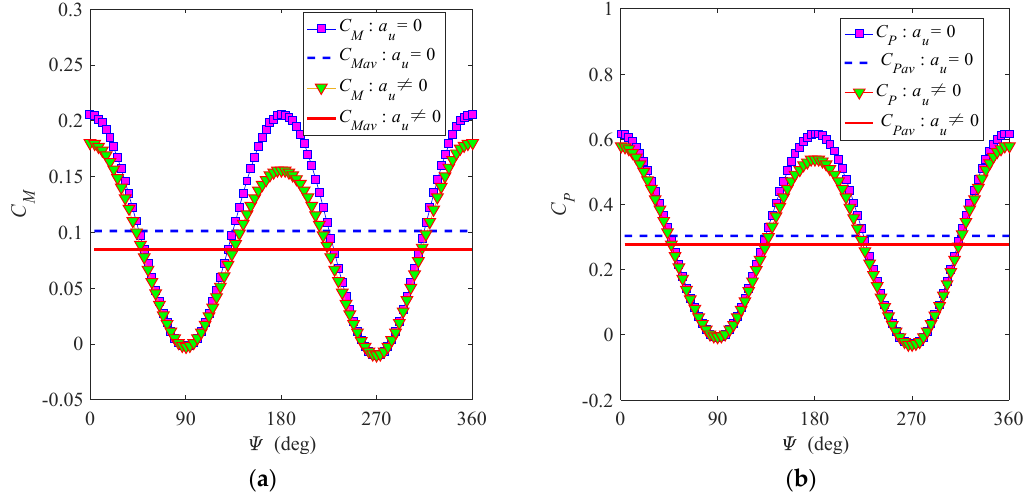
Figure 12. Variations of ( a ) the instantaneous torque coefficient and ( b ) instantaneous power coefficient with the azimuth at R = 3.79 m, Ω = 37.84 rpm, θ p = 0°, and v in = 11.18 mph.